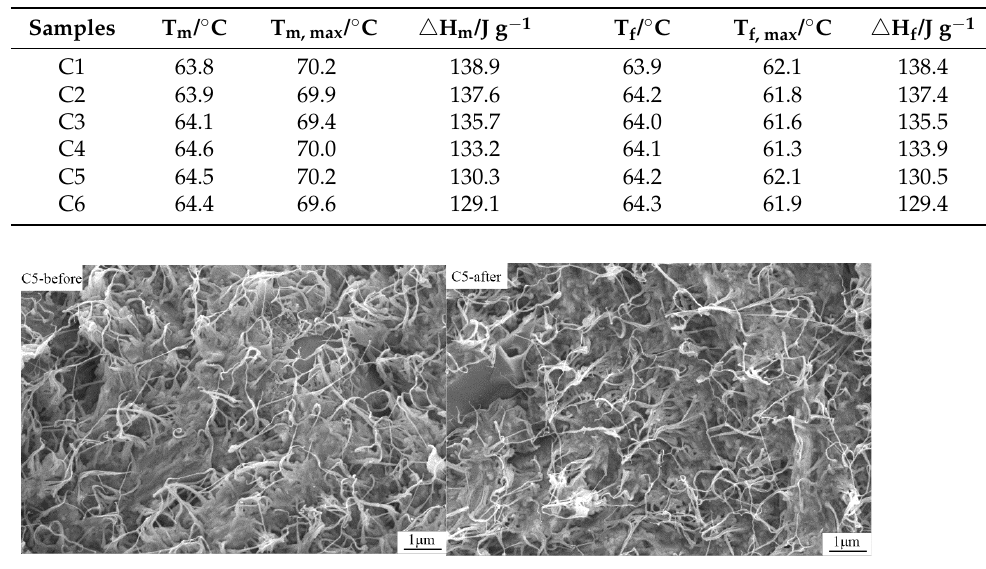
Figure 8. SEM images of CNT-PE-EPDM/EG-based PCM sample C5 before heating-cooling test and after 200 cycles.